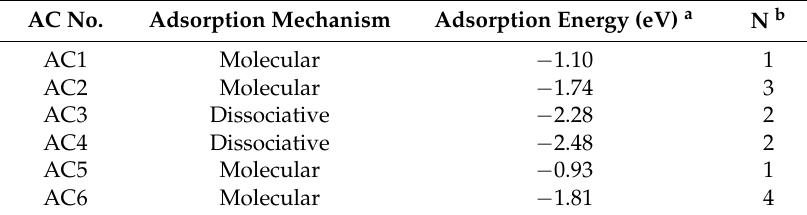
Table 3. Adsorption mechanism, adsorption energy and the net number of formed bonds for each adsorption configuration. The AC No. 1–6 corresponds to (a)–(c) in Figures 5 and 6.